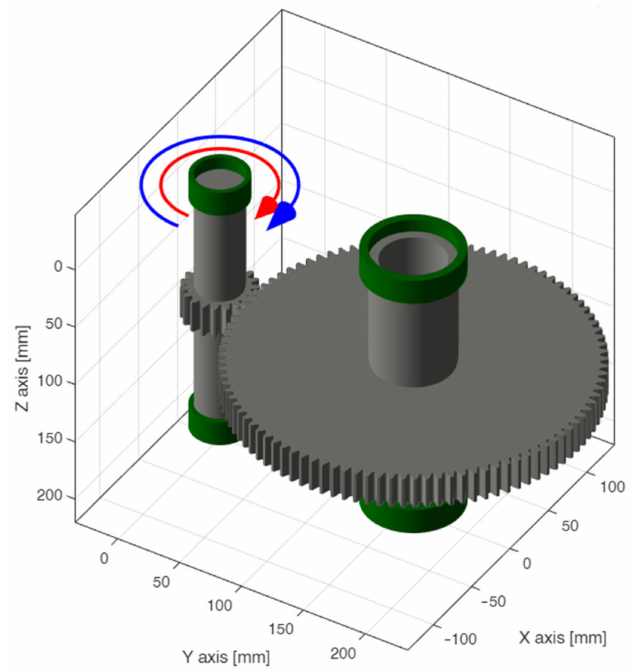
Figure 5. Test transmission model in the GeDy TrAss software.